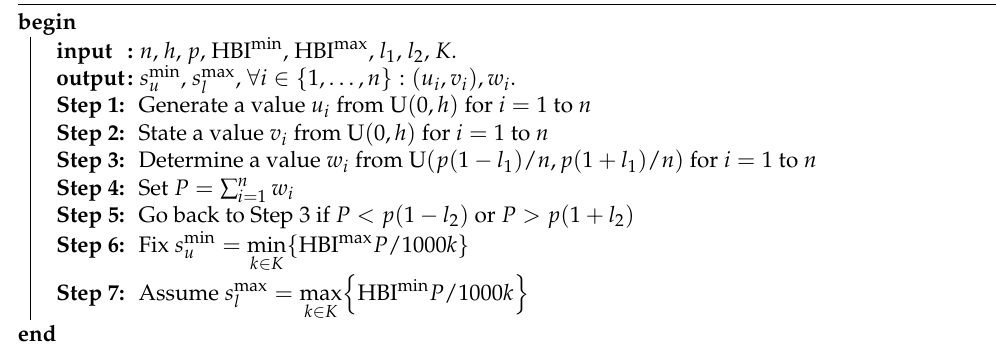
Algorithm 2 Simulation algorithm for generating instances of the location problem for healthcare